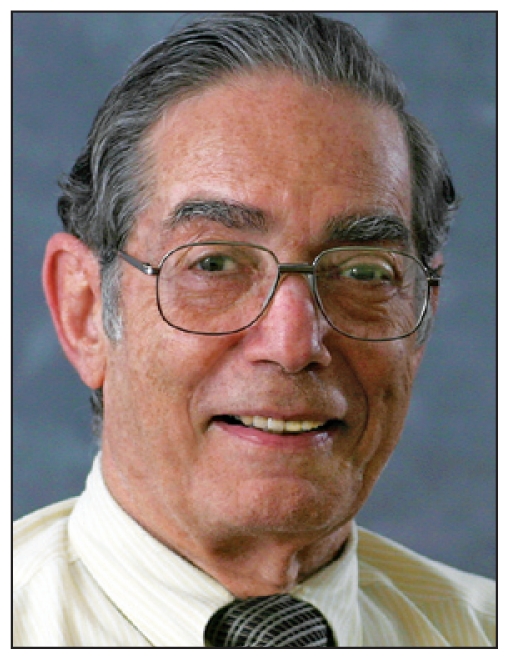
Morton Lippmann